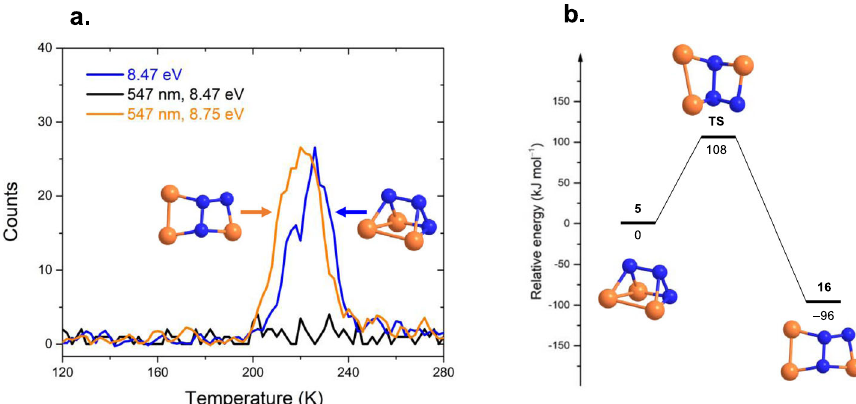
Fig. 5 Photoisomerization of 1,2,3-Triaza-4,5,6-triphosphatetracyclo [2.2.0.0 2,6 .0 3,5 ]hexane (P 3 N 3 , 5) by 547 nm laser irradiation. a PI-ReTOF-MS signal at m/z = 135 detected during the TPD phase of the electron and 547 nm laser processed phosphine – nitrogen ice mixture; b potential energy surface (PES) for the isomerization of 5 – 16 . The energies were computed at the CCSD(T)/CBS//B3LYP/cc-pVTZ level of theory including zero-point vibrational energy (ZPVE) corrections. The atoms are color coded in blue (nitrogen) and orange (phosphorous).